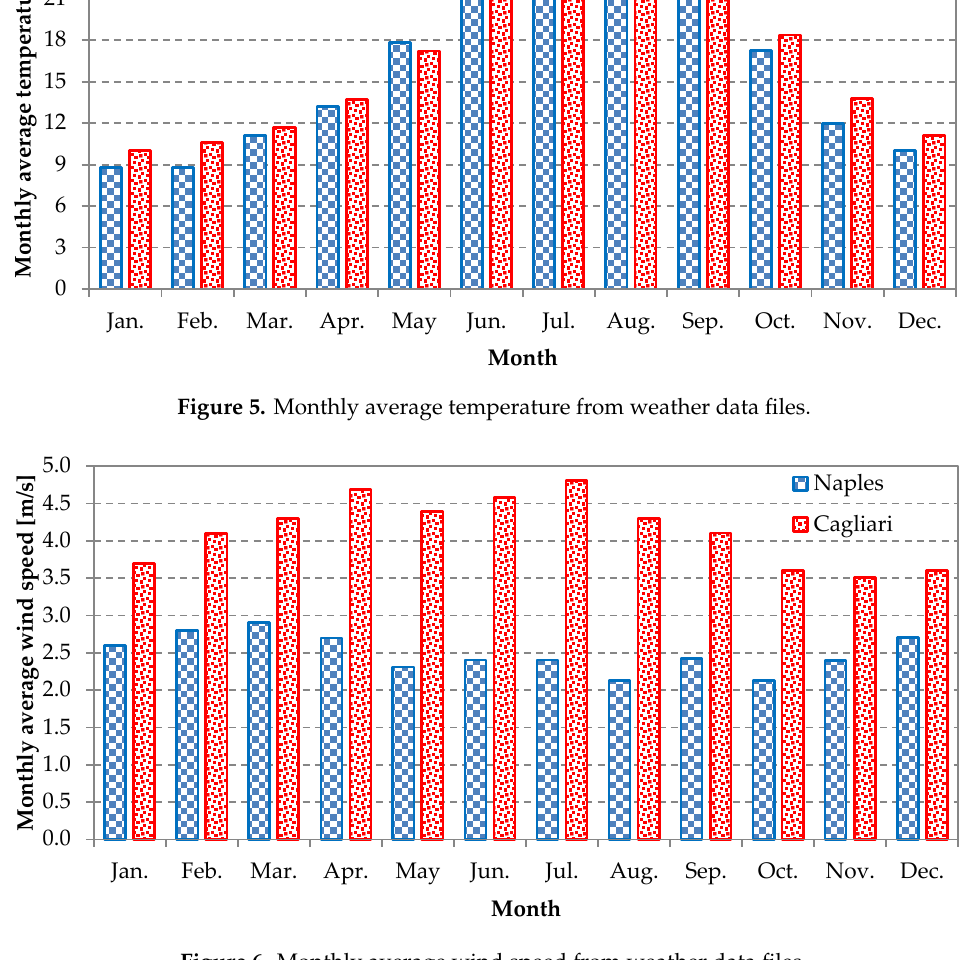
Figure 6. Monthly average wind speed from weather data files.